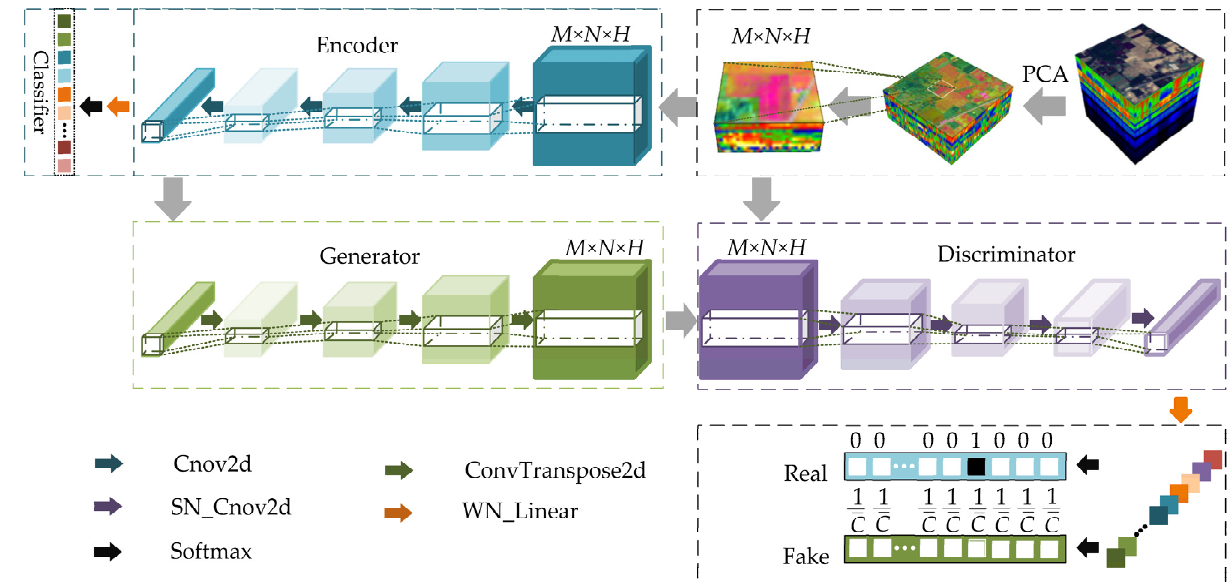
Figure 1. Structure diagram of the ARL-GAN algorithm.